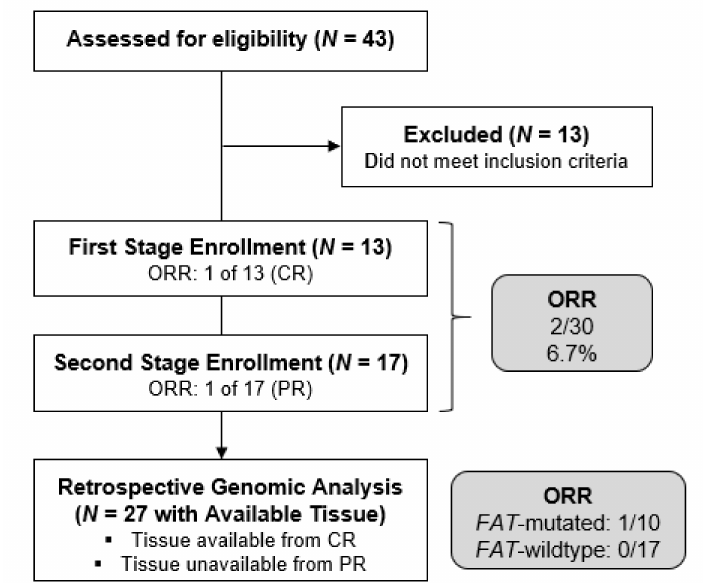
Figure 1. CONSORT